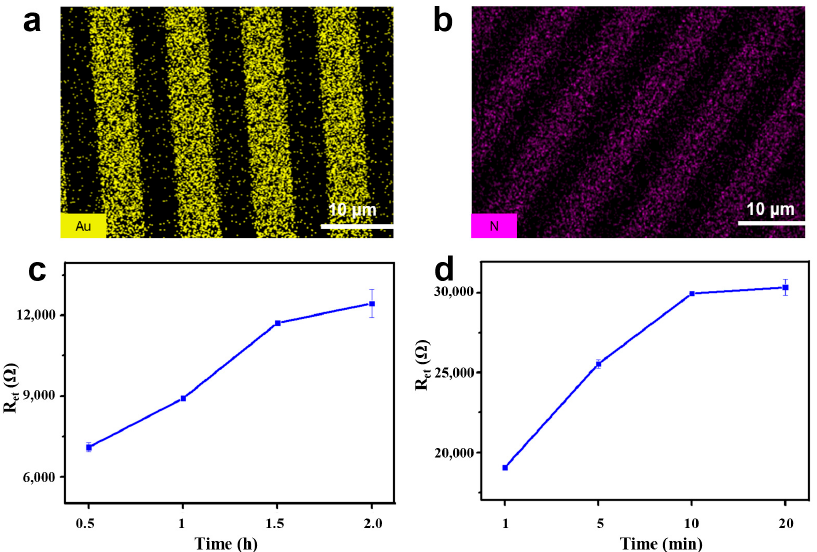
Figure 6. ( a ) The energy-dispersive spectrometry (EDS) spectrum characterization of the bare gold electrode. ( b ) Elemental mapping images of the Nbs modified gold electrode. ( c ) The optimized of immobilization time of the Nb. ( d ) The opti- mized of the immunoreaction time.